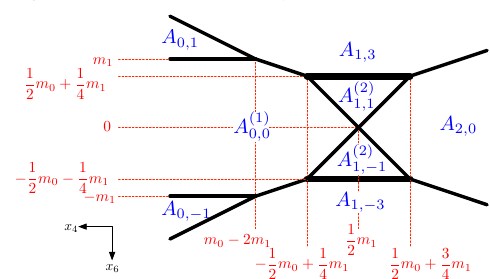
Figure 29. The regions for the largest A ( m ) Region 9 of the E 2 theory.